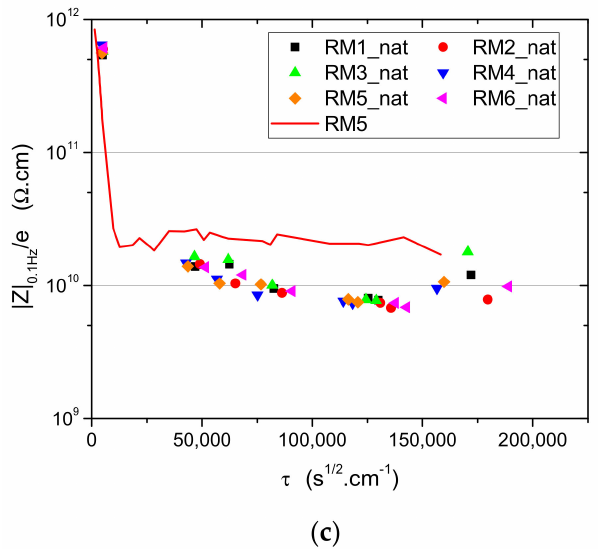
Figure 6. Evolution of | Z | 0.1 Hz /e vs. reduced time for the ageing in natural seawater for ( a ) ROX system, ( b ) RG system, and ( c ) RM